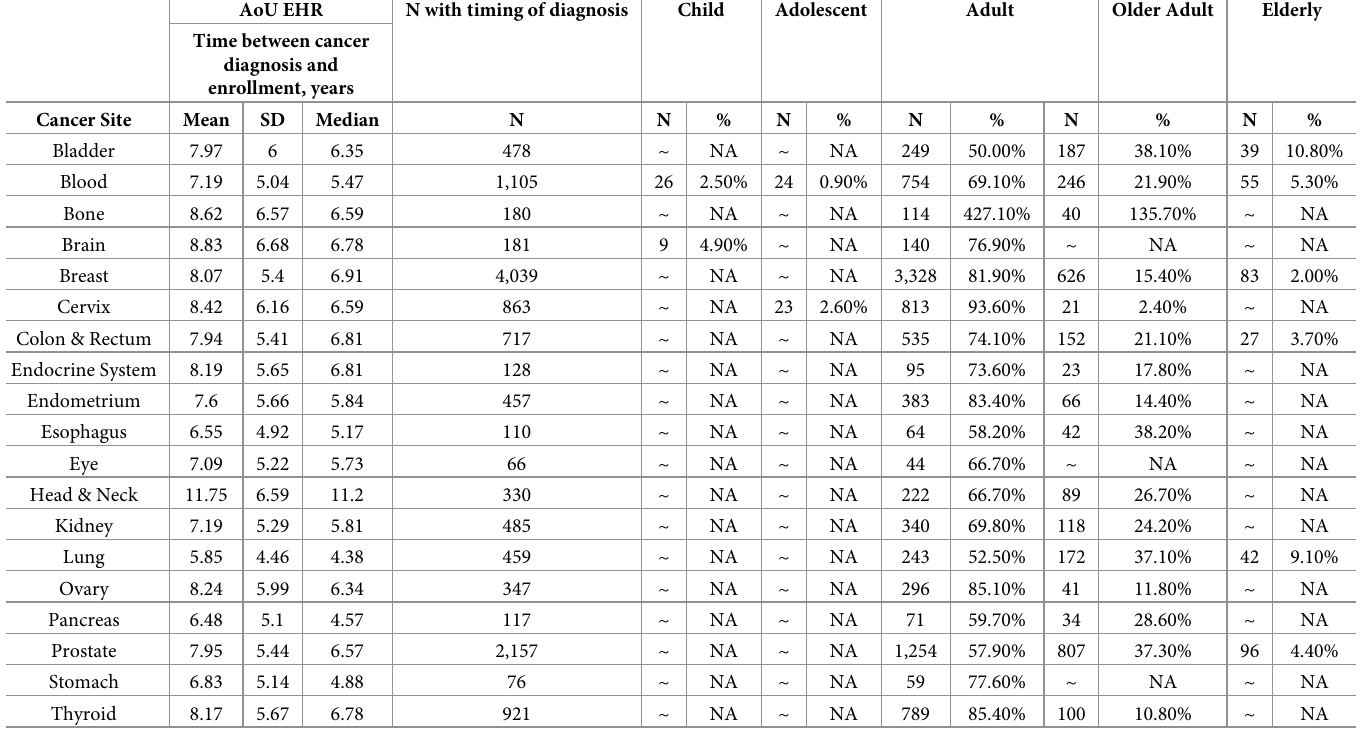
Table 5. Time from diagnosis of cancer cases and approximate age at diagnosis by type in the All of Us Research Program. AoU EHR N with timing of diagnosis Time between cancer diagnosis and